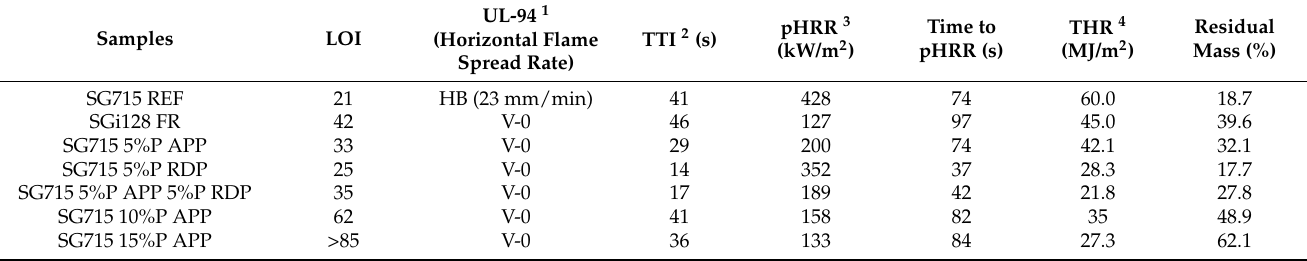
Table 3. Limiting oxygen index (LOI), UL-94, and mass loss calorimetry (MLC) results of gelcoats.